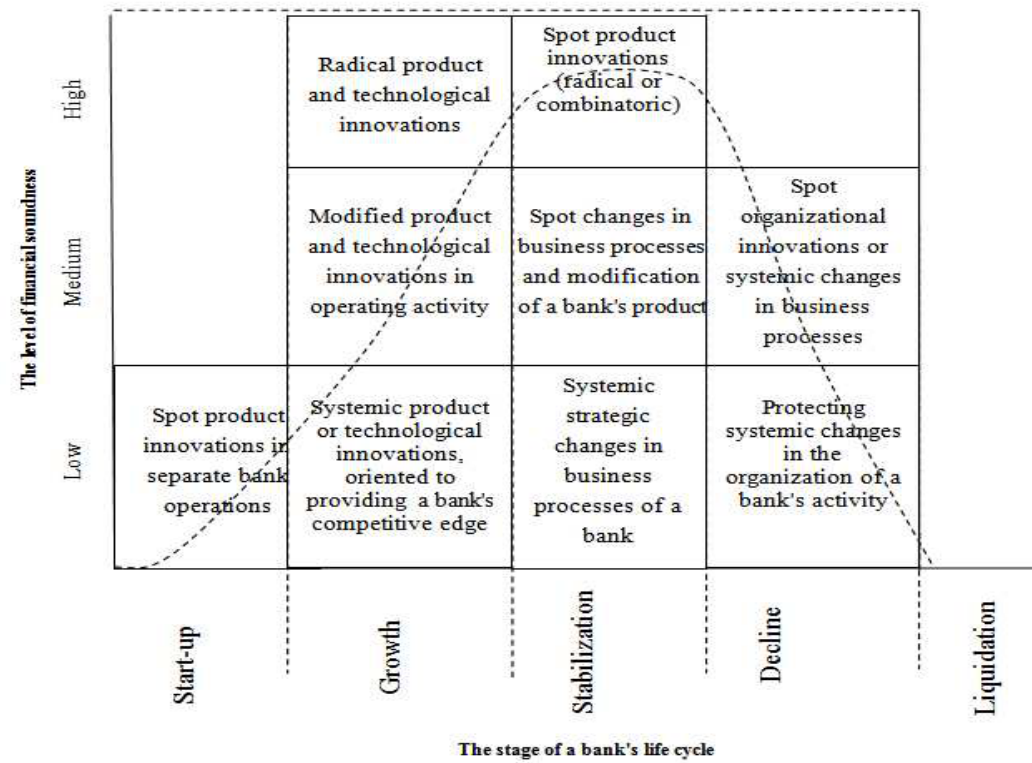
Fig. 4. Types of bank financial innovations depending on the stage of a bank’s life cycle and the level of its financial stability Source: elaborated by the